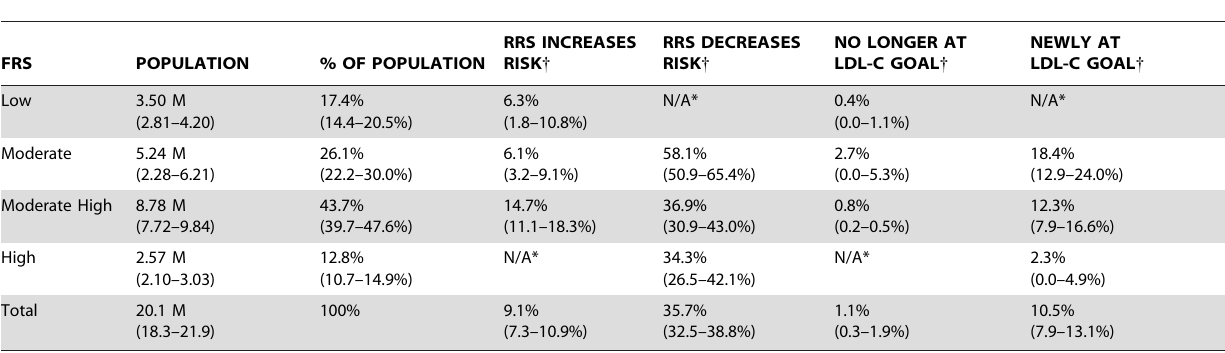
Table 5. Reynolds Risk Score Applied to Population of U.S. Men.